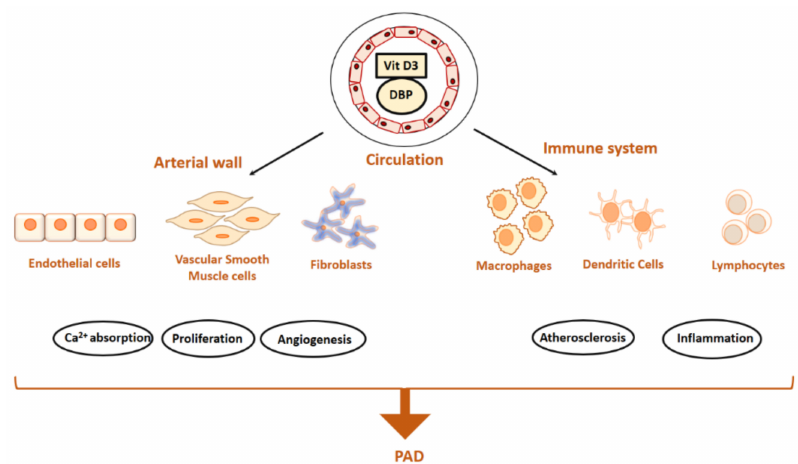
Figure 3. Schematic illustration summarising the e ff ect of vitamin D on various resident cells and its role in modulating the molecular mechanism involved in PAD formation. Vitamin D has been proposed to be involved in the regulation of many cell types involved in PAD formation, mainly the residential vascular cells such as endothelial cells, vascular smooth muscle cells, firboblasts and also infiltrating and / or circulating immune cells. Vitamin D has shown to be potent growth modulator, protector of endothelial function and inflammatory response mediator on the resident vascular cells playing a crucial role in atherogenesis. Optimal vitamin D status is crucial for the functioning of the resident cells and thus it plays a major protective e ff ect in vascular wall promoting matrix